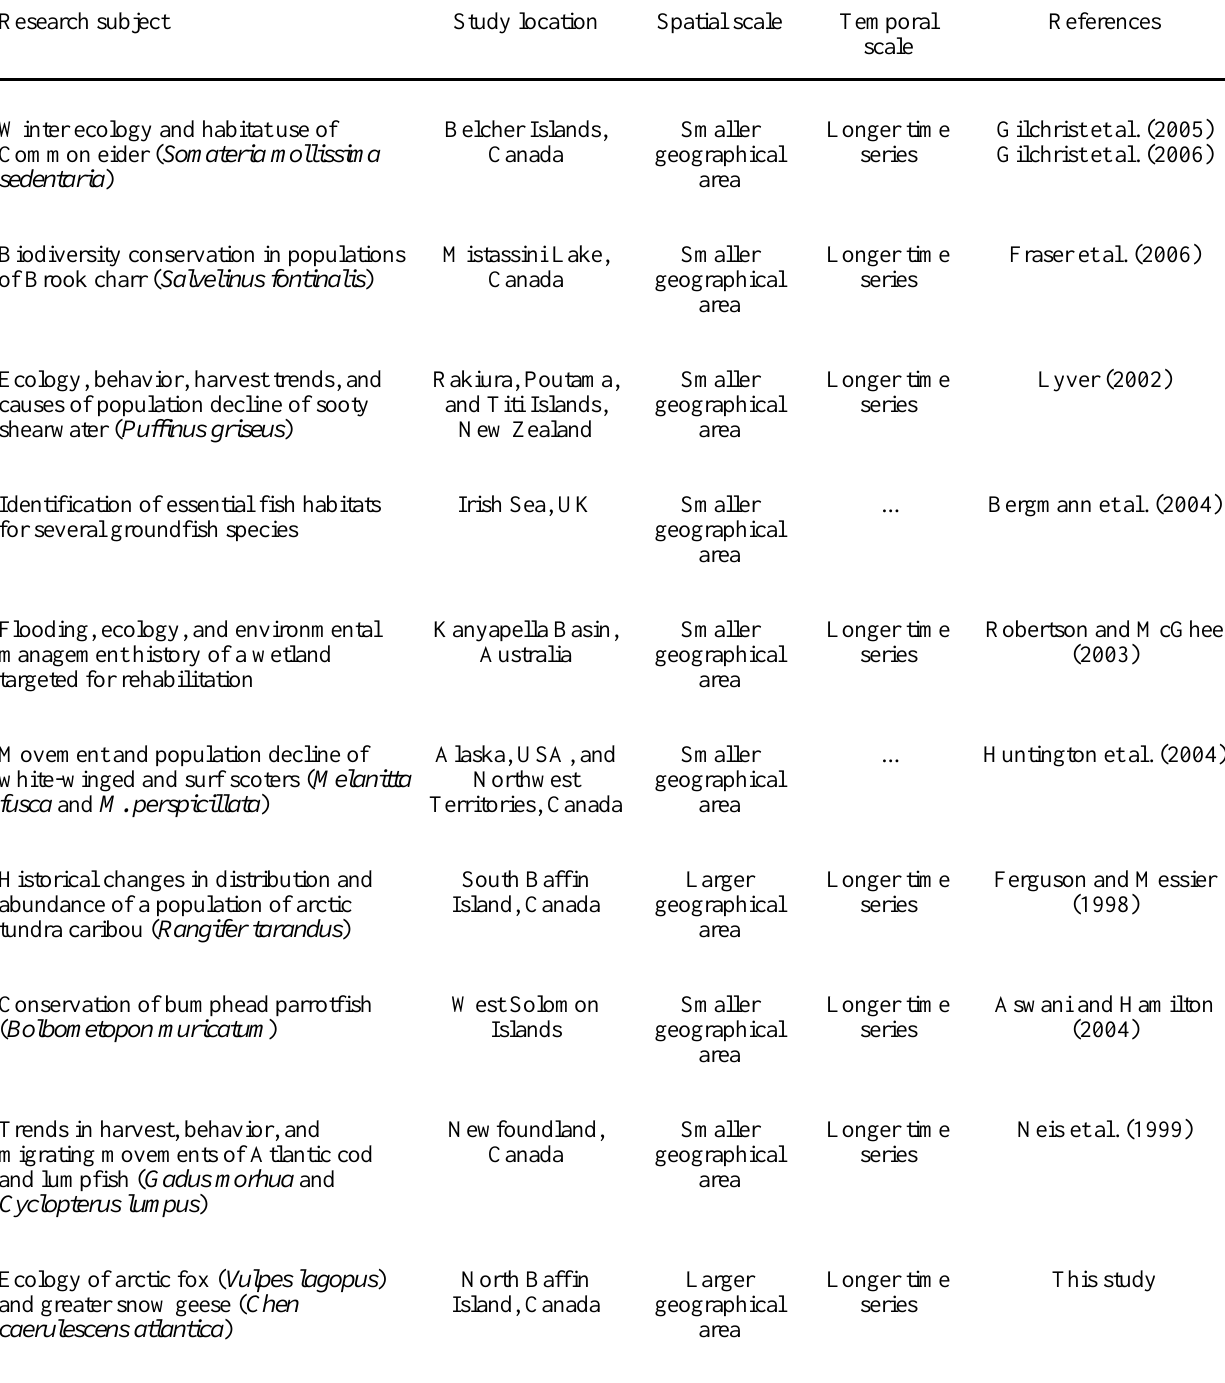
Table 1 . Representative examples of studies combining traditional ecological knowledge (TEK) and scientific knowledge. The summary describes whether TEK provided a smaller/larger or shorter/longer scale of spatial and temporal information compared to available scientific